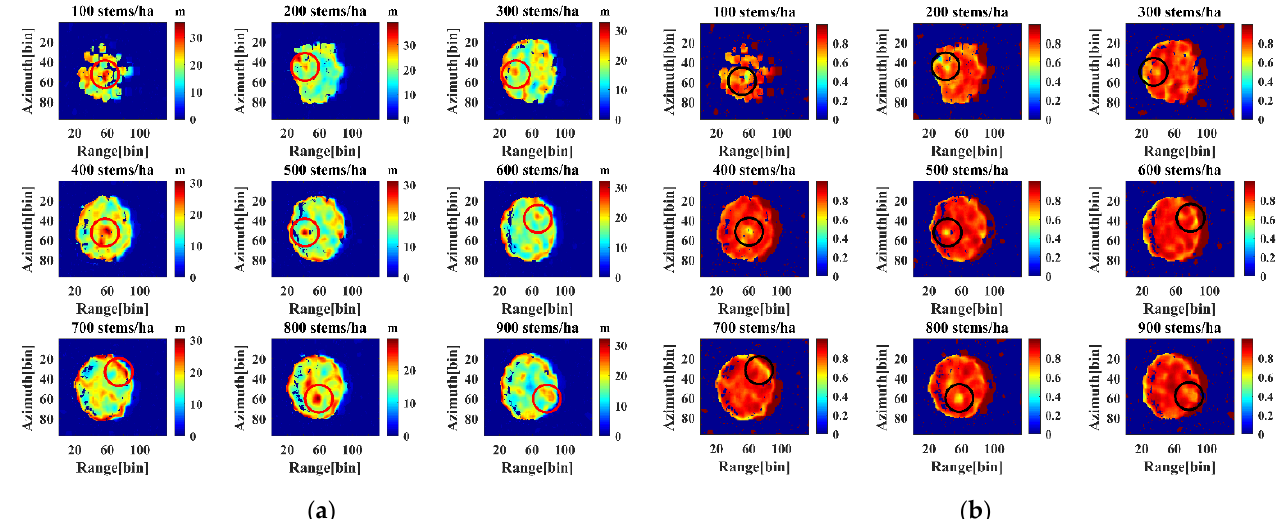
Figure 10. In the SINC inversion method, two-dimensional images of tree height and HV polarization intensity are generated for nine groups of forest stands. ( a ) A two-dimensional map of forest height for nine groups of forest stands. ( b ) A two-dimensional map of the HV magnitude for nine groups of forest stands. For each of the nine groups of forest stands, the black circles indicate the regions with low amplitude values. The red and black circles are positioned in the same location in both images.